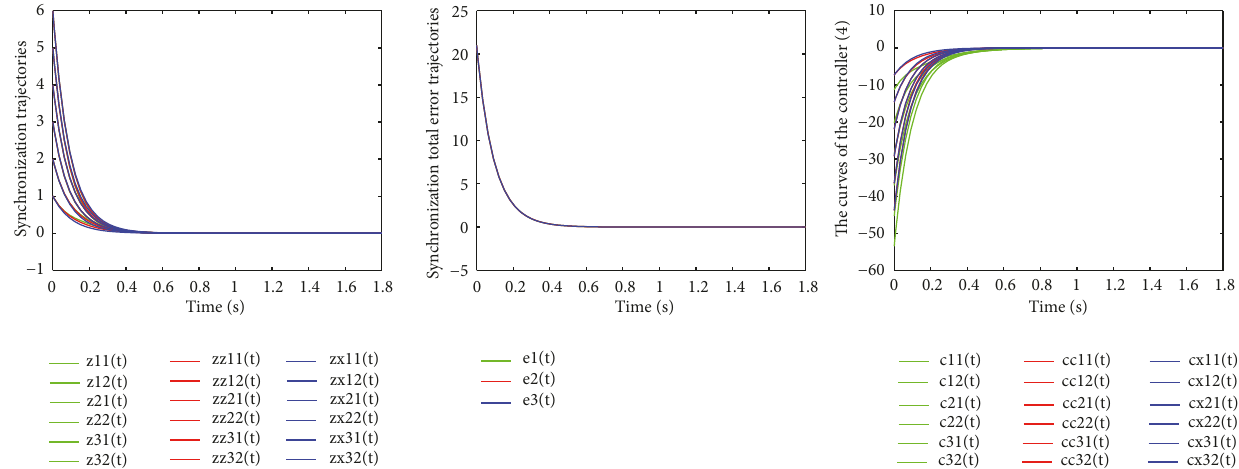
Figure 4: Synchronization trajectories, synchronization total error trajectories of network (1) with controller (4) and the curves of controller (4) for Case IV of Example 25.